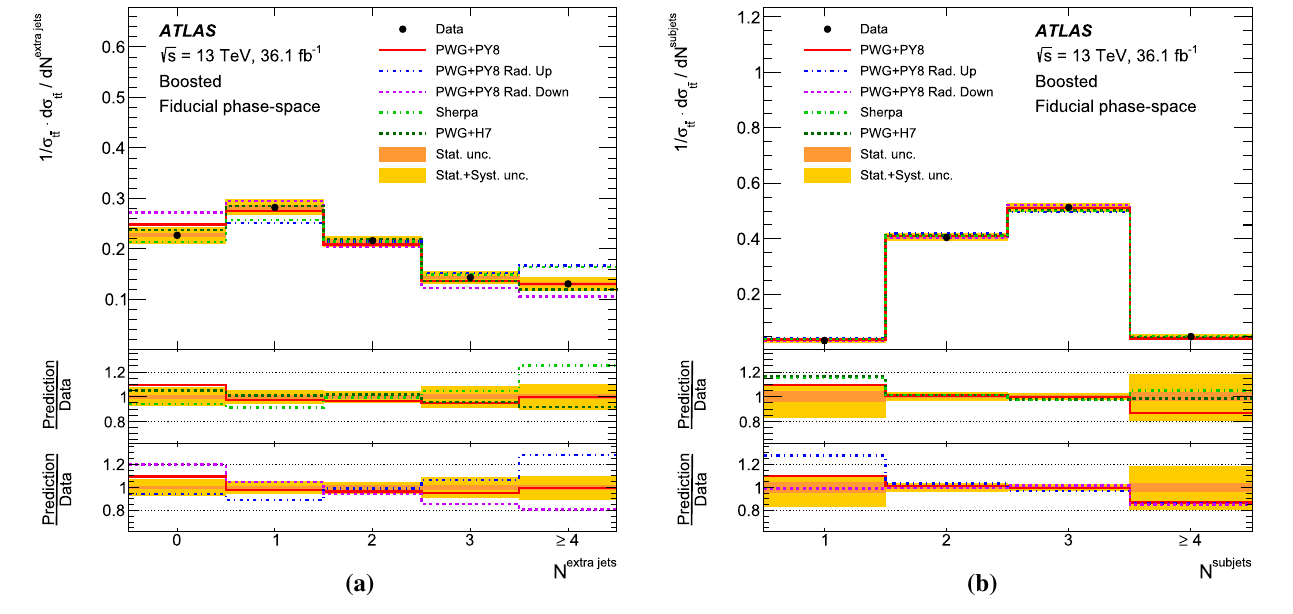
p -value are calculated using the covariance matrix of the measured spectrum. The NDF is equal to the number of bins in the distribution minus